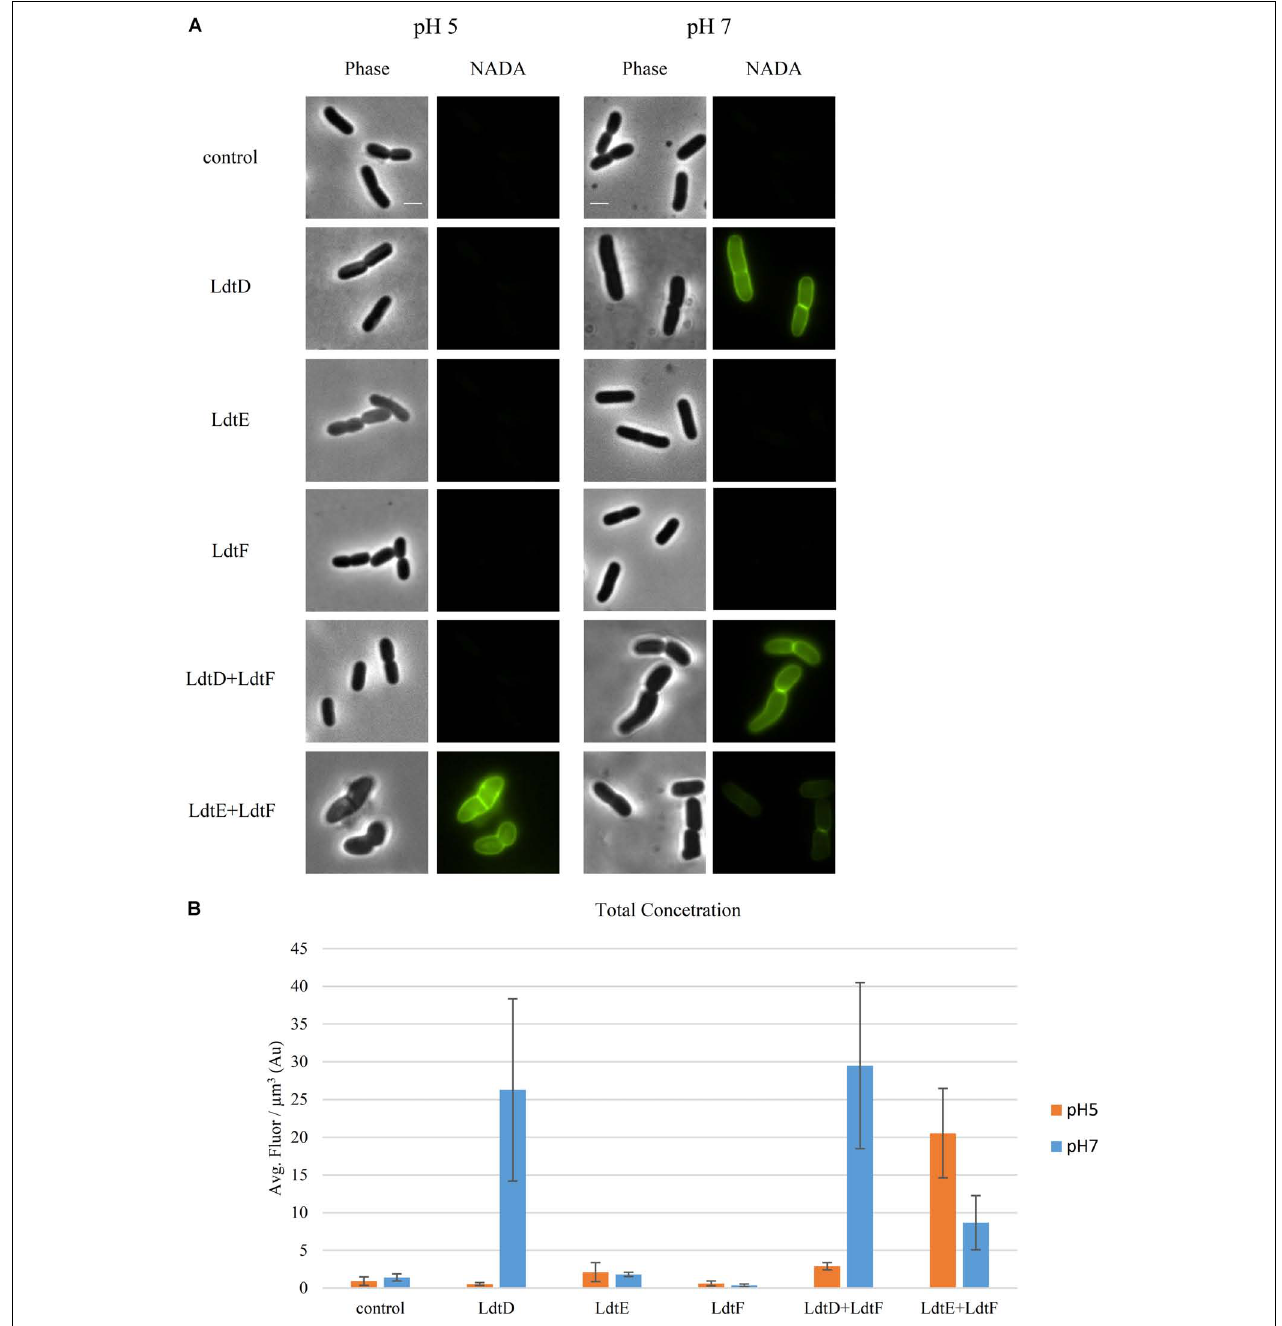
FIGURE 2 | Incorporation of NADA is pH dependent. (A) Phase contrast and corresponding fluorescence images of BW25113 (cid:49) 6LDT cells not expressing (control) or expressing ldtD , ldtE , ldtF , ldtD and ldtF , or ldtE and ldtF at pH 5.0 or 7.0, and labeled with NADA. Cells were grown to exponential phase in LB at 37 ◦ C. LD-TPase genes expression was induced for two mass doubling with 50 µ M IPTG, and the NADA pulse was for 2 min. Scale bar, 2 µ m. (B) Concentration of NADA in cells of BW25113 (cid:49) 6LDT strain not expressing (control) ( n = 1000 at pH 5; n = 1216 at pH 7) or expressing ldtD ( n = 903 at pH 5.0; n = 1329 at pH 7.0), ldtE ( n = 768 at pH 5.0; n = 2116 at pH 7.0), ldtF ( n = 331 at pH 5.0; n = 1335 at pH 7.0), ldtD and ldtF ( n = 294 at pH 5; n = 518 at pH 7), or ldtE and ldtF ( n = 444 at pH 5.0; n = 530 at pH 7.0). The values are mean ± SD of n number of cells.